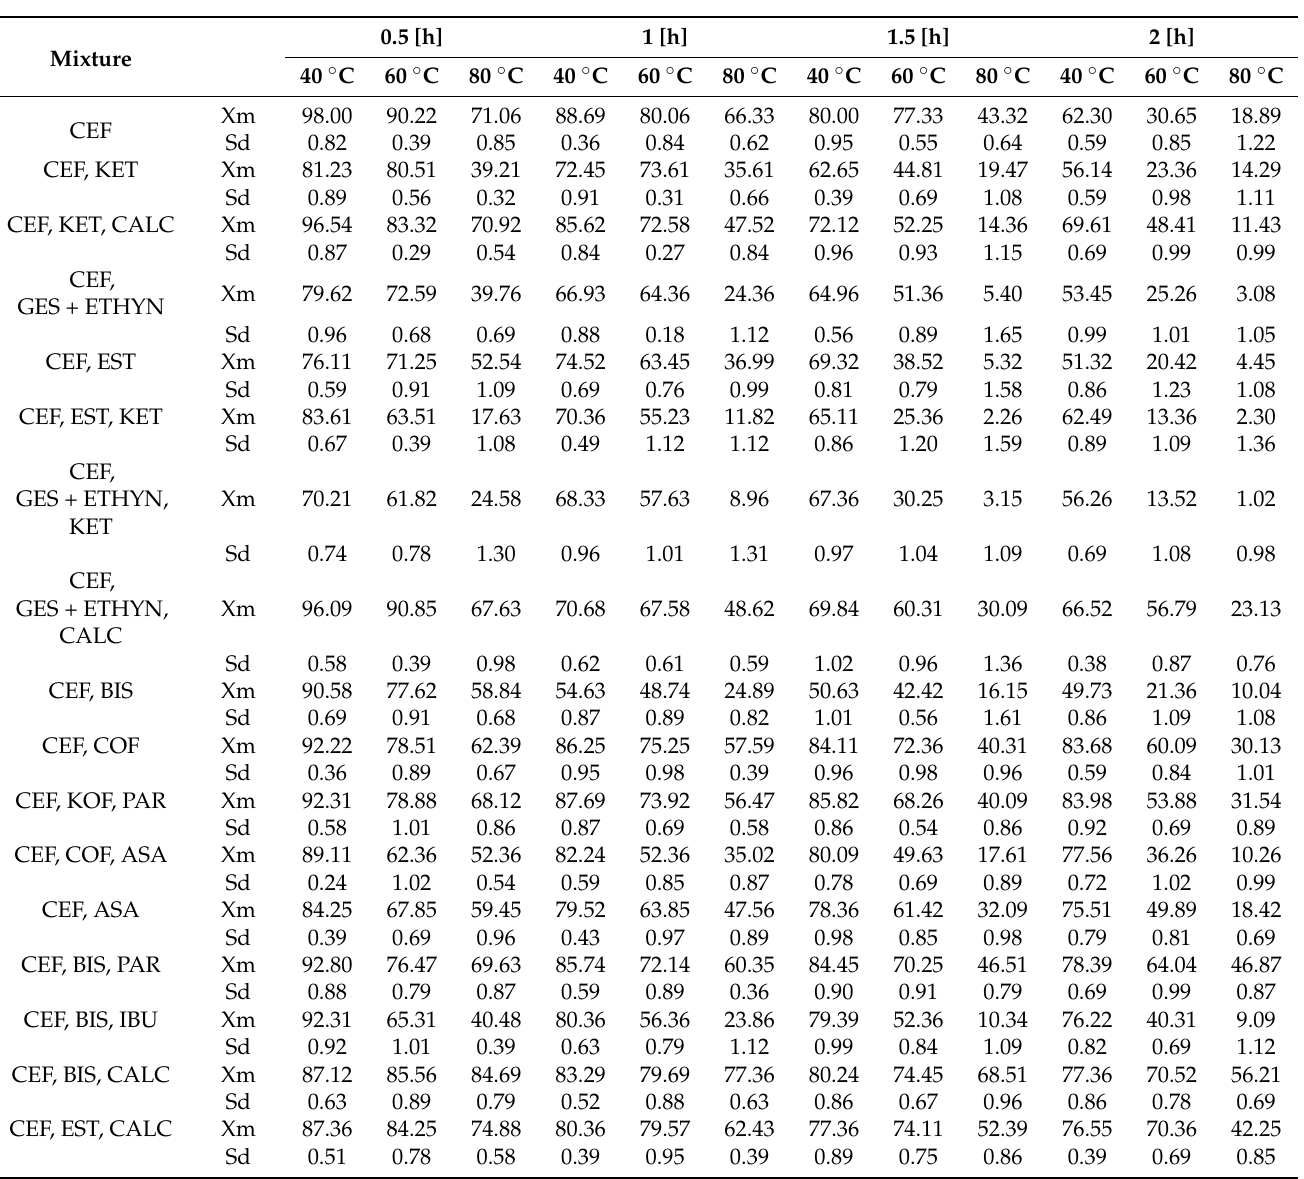
Table 2. Concentration [%] changes of cefepime in various drug mixtures during incubation at 40, 60 and 80 ◦ C ( n =